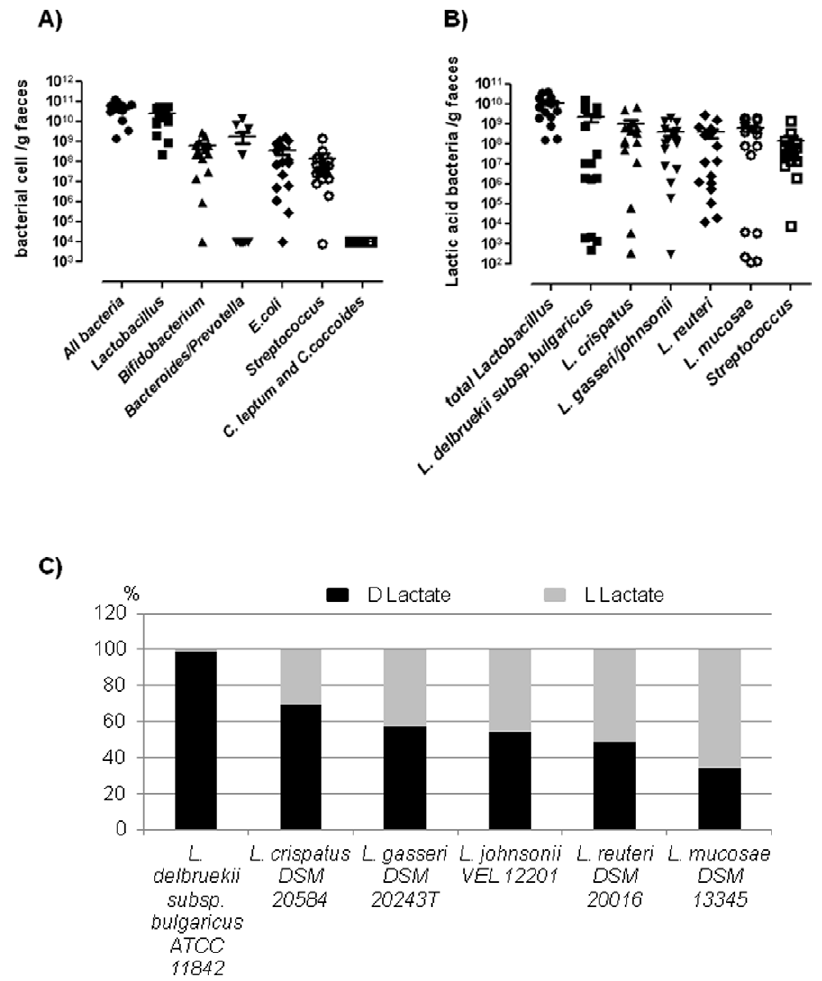
Figure 1. Composition of faecal microbiota in SBS patients and invitro metabolic activity of lactic acid bacteria. A- Level of dominant and subdominant bacteria in the SBS faecal microbiota (expressed as the mean of bacterial cell/g faeces, mean value and individual values). Lactobacillus represented the Lactobacillus/Leuconostoc group determined by qPCR. B- Level of different lactic acid bacteria species in SBS faecal microbiota (lactic acid bacteria/g faeces, mean value and individual values). C- In vitro D and L lactate production of different reference species of Lactobacillus , during 24 hours (results were expressed in % of total D and L lactate in the medium).